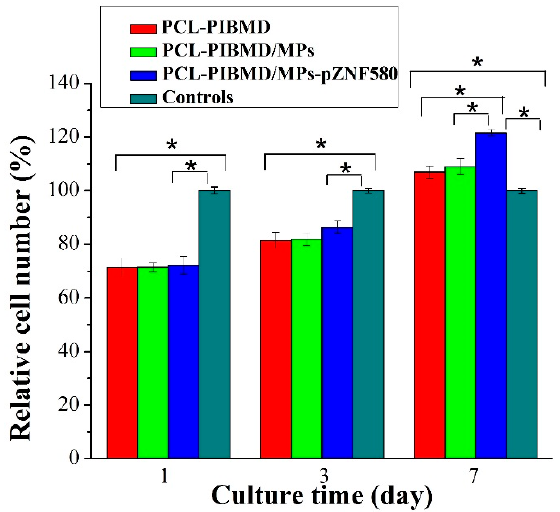
Figure 5. The relative cell number of EA.hy926 cells cultured on PCL-PIBMD, PCL-PIBMD/MPs, and PCL-PIBMD/MPs-pZNF580 meshes for 1, 3, and 7 days. Error bars represent mean ± standard deviation (SD) ( Fisher LSD test was performed to determine statistical significance between groups, * p < 0.05).